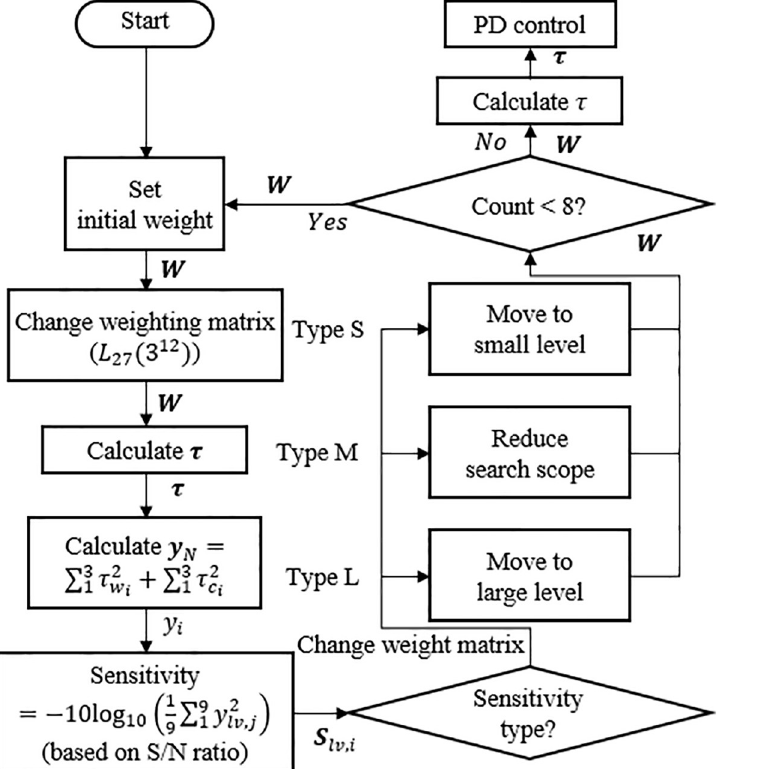
Fig 7. Weighting matrix determination